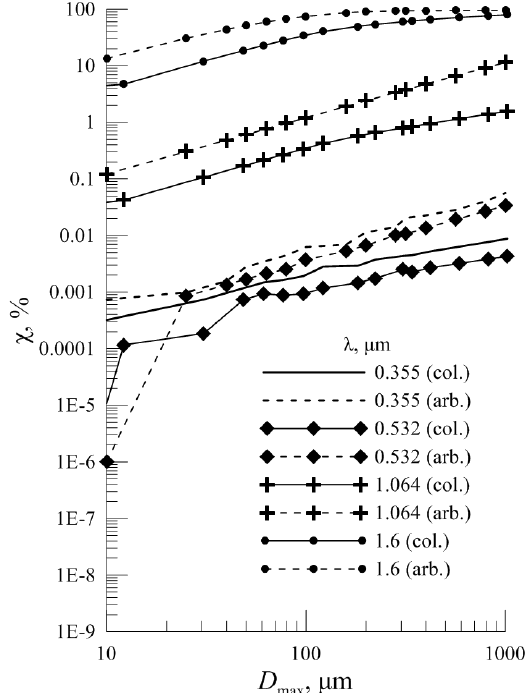
Figure 2 Dependence of D hexagonal column and the arbitrary formed particle